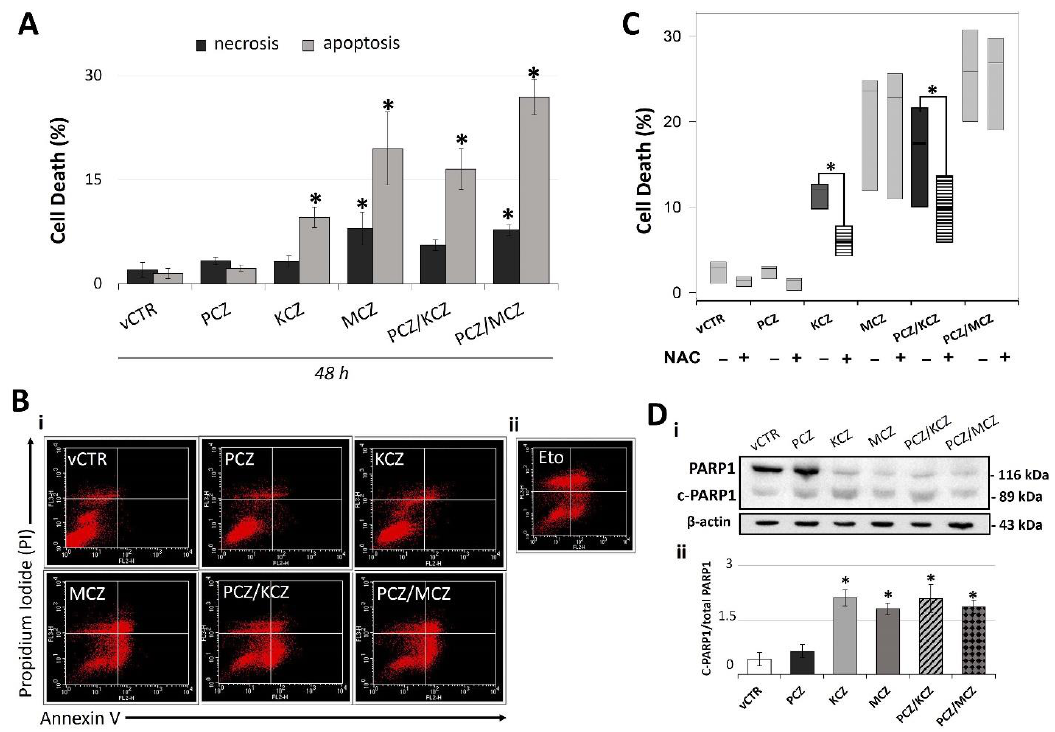
Figure 4. Possible ROS-dependent apoptotic activity of azole drugs in TM4 cells. ( A ) Graph repre- senting the percentage of apoptotic and necrotic cells in experimental groups exposed for 48 h to PCZ, KCZ, MCZ, and mixtures. Data from three independent experiments are expressed as mean ± SE; one-way ANOVA followed by Dunnett’s test; * p < 0.05 vs. vCTR. ( B , i ) Representative images of cytofluorometric profiles of cells stained with annexin V and PI after 48 h of incubation in the absence (vCTR) or in the presence of azoles. ( B , ii ) Cells treated with 25 µM etoposide (Eto) for 24 h were used as a positive control for apoptosis induction. Upper left quadrant = necrosis; upper right quadrant = late apoptosis; lower right quadrant = early apoptosis. ( C ) Analysis of cell death (%) in samples treated or not treated (vCTR) with azoles at 48 h of incubation, in the presence (+) or in the absence (−) of the inhibitor of ROS (1 mM NAC). NAC = N-acetyl-cysteine. Values are expressed as the mean of three independent experiments ± SE; one-way ANOVA, Dunnett’s test; * p < 0.05 vs. vCTR. ( D , i ) Representative images of C-PARP1 Western blotting and ( D , ii ) protein expression levels of C-PARP1 (89 kDa) at 48 h exposure to azoles. Band density was performed by using Image-J software. The bar graph represents data from three independent experiments as ratios of cleaved PARP1 to total PARP1 ± SE; ß-actin was used as loading control. one-way ANOVA, followed by Holm–Sidak method; * p < 0.05 vs.